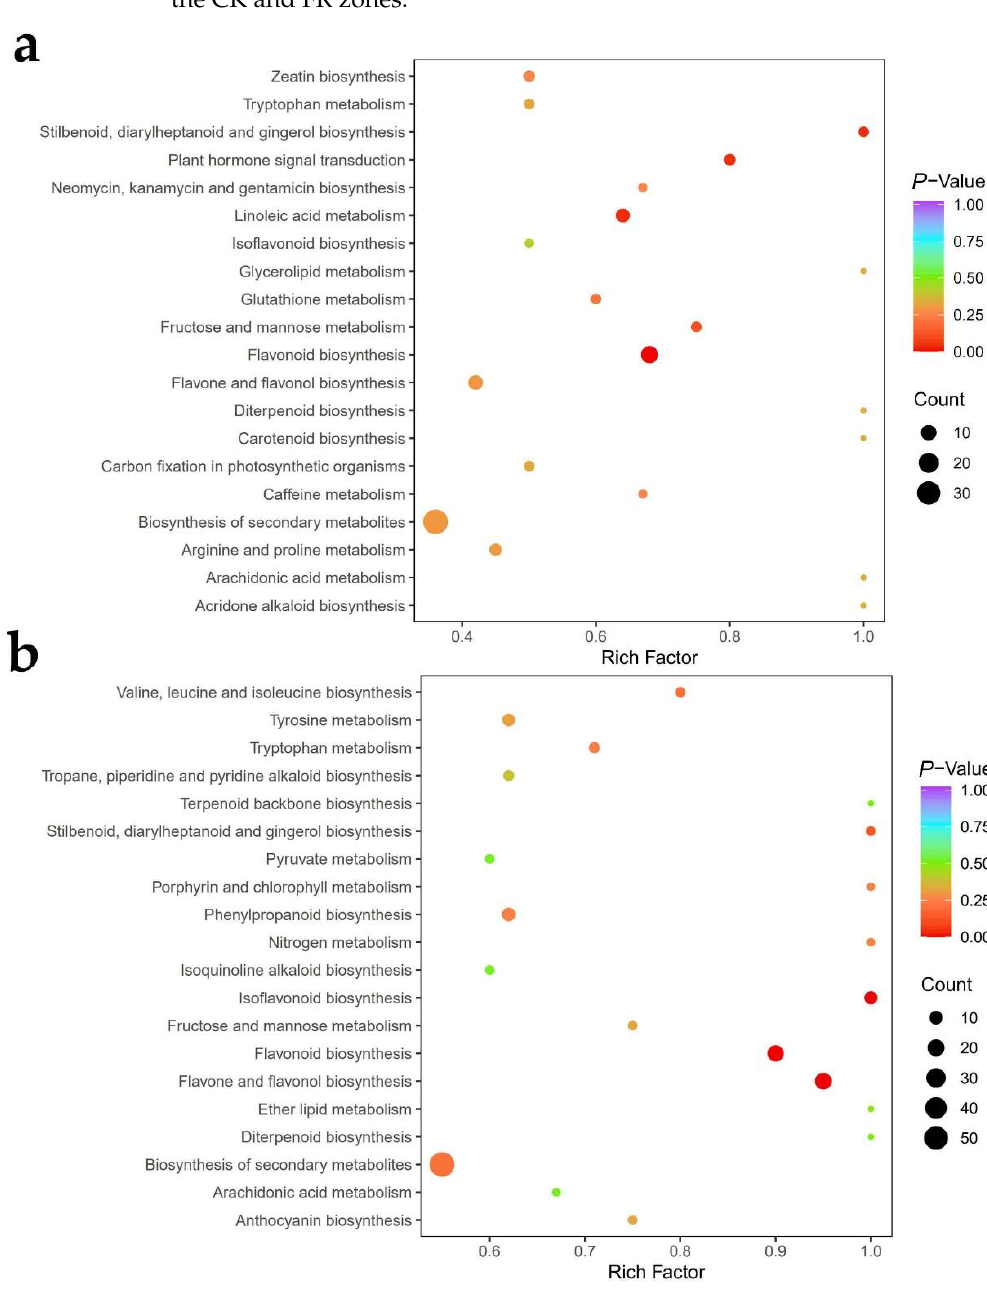
Figure 7. KEGG enrichment analysis of differential metabolites between the CK and FR comparison groups (Leaf-CK vs. Leaf-FR, Root-CK vs. Root-FR). ( a ) represent leaves and ( b ) represent roots. Each bubble in the plot represents a metabolic pathway; the abscissa and the bubble size jointly indicate the magnitude of impact. A larger bubble shows more metabolites are enriched; the bubble color represents the p -value of the enrichment analysis, with darker colors indicating a higher degree of enrichment.